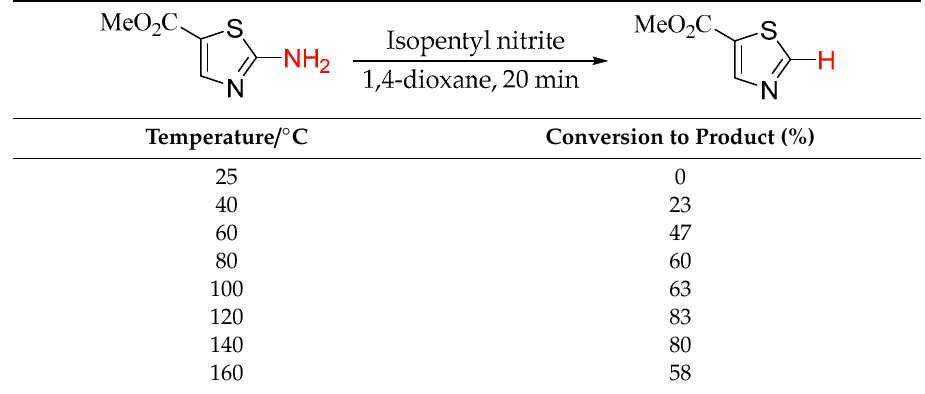
Table 3. Conversion of methyl 2-aminothiazole-5-carboxylate ( 1a ) to methyl thiazole-5-carboxylate ( 2a ) at various temperatures in 1,4-dioxane.